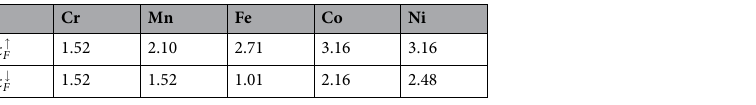
Table 1. Extracted values of ↑ ↓ k